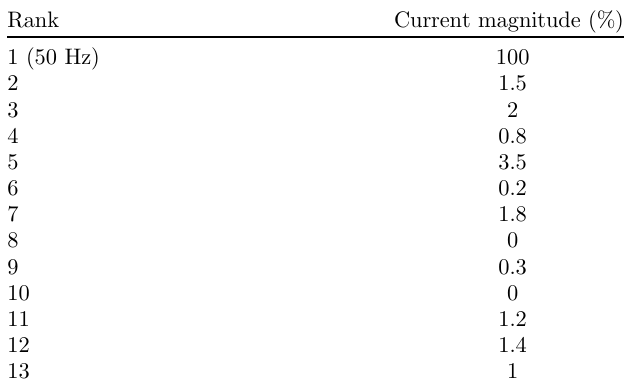
Table 5. Current harmonics as a percentage of the fundamental (measured on site).